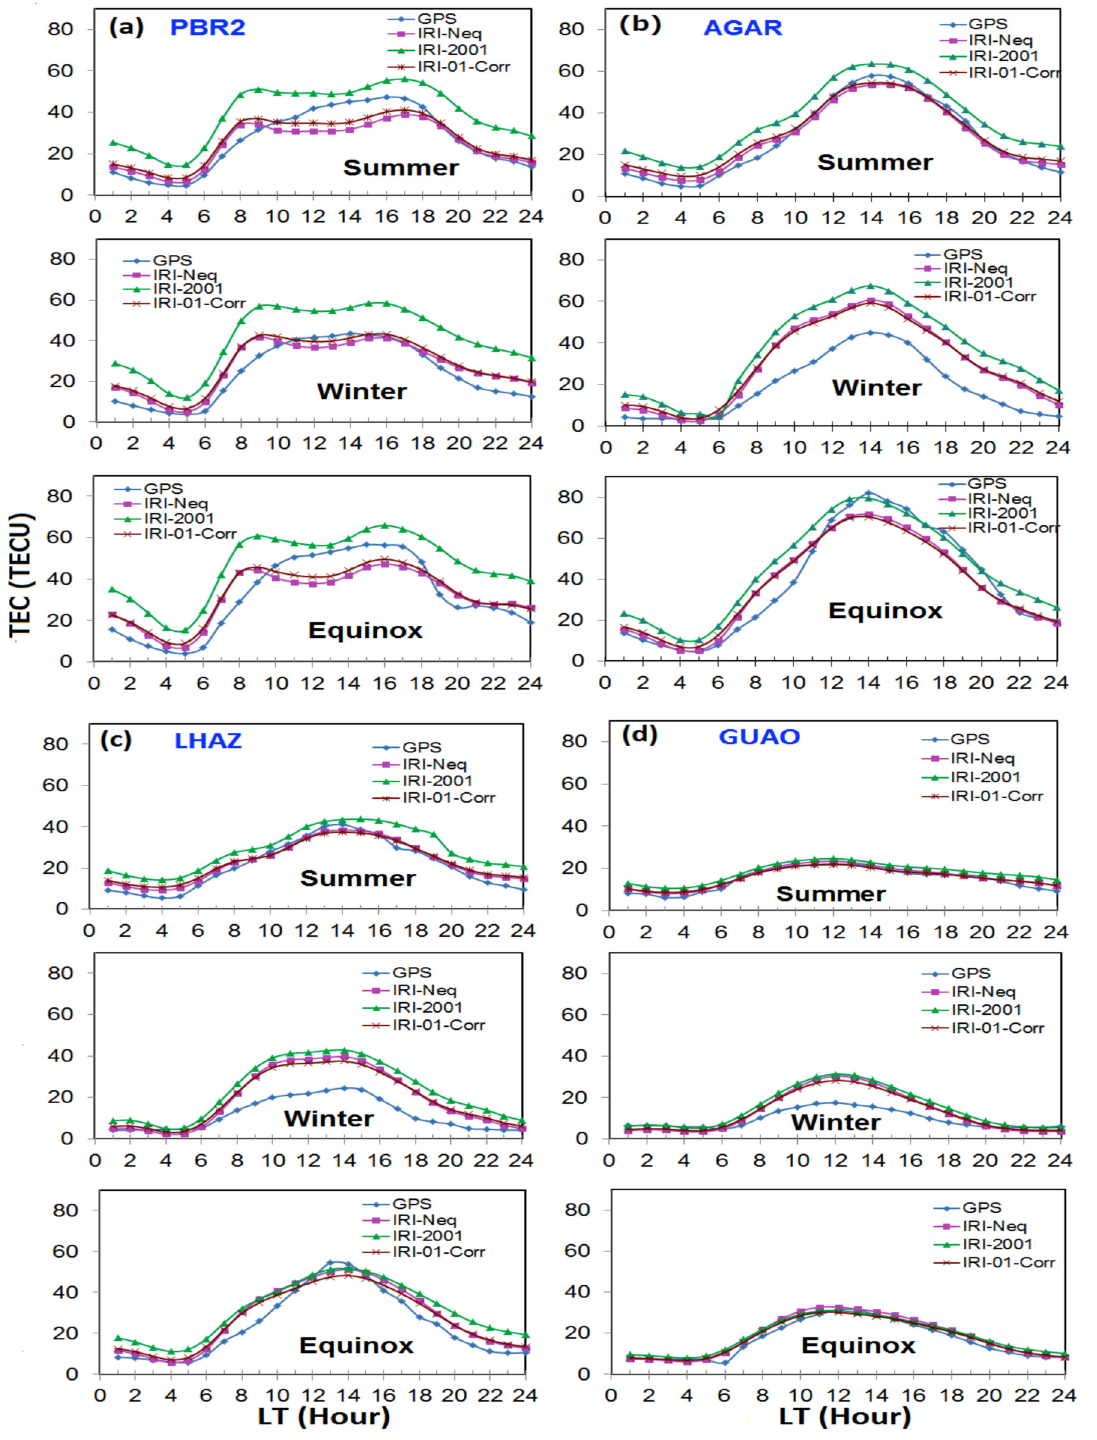
Figure 7. Seasonal variation of GPS-TEC and its comparison with IRI 2012 model TEC at (a) Port Blair (Geomagnetic lat. 2.11°N) (b) Agar- tala (Geomagnetic lat. 14.22°N) (c) Lhasa (Geomagnetic lat. 20.09°N) and (d) Urumqi (Geomagnetic lat.